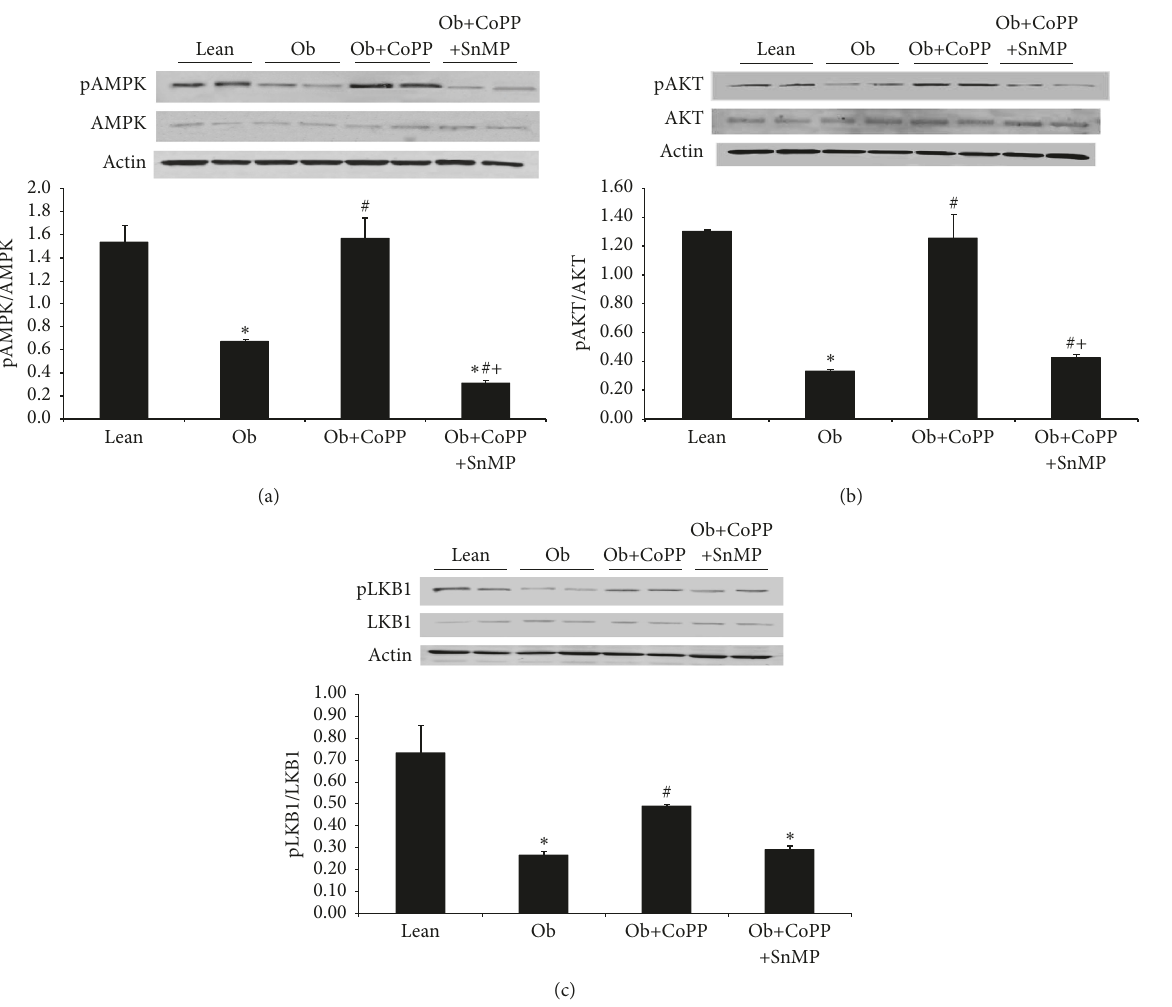
Figure 5: Effect of CoPP and SnMP administration on pAMPK/AMPK and pAKT/AKT protein levels in liver of lean and obese mice. (a) Total and phosphorylated AMPK, and pAMPK/AMPK, (b) total and phosphorylated AKT, and pAKT/AKT, and (c) total and phosphorylated LKB1, and pLKB1/LKB1. Results are mean ± SEM, 𝑛 = 3 -4, ∗ 𝑝 < 0.05 versus lean; # 𝑝 < 0.05 versus obese; + 𝑝 < 0.05 versus obese